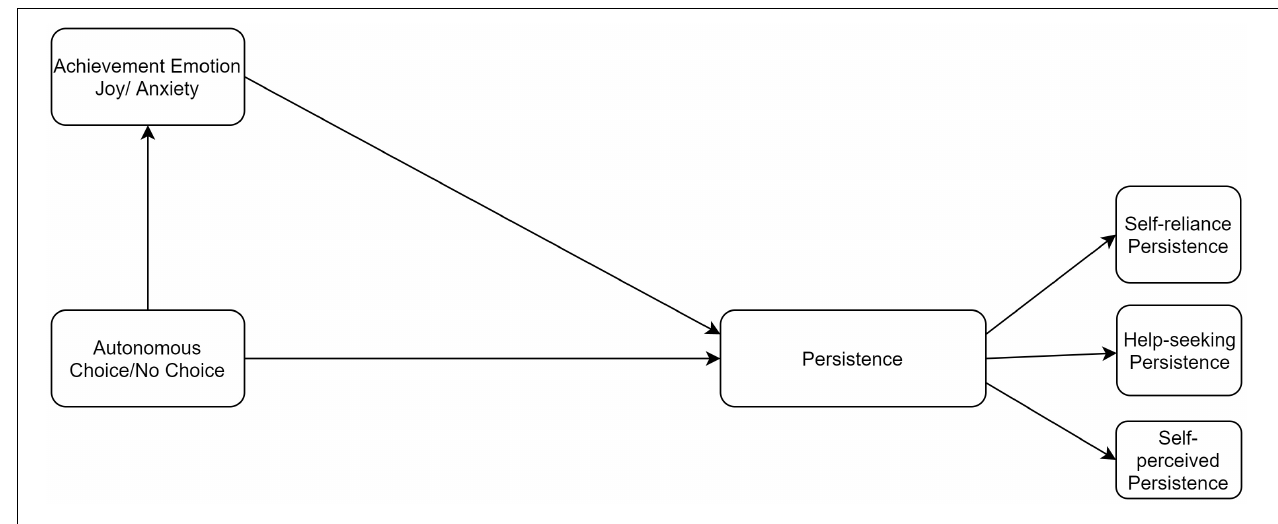
FIGURE 1 | Theoretical framework.